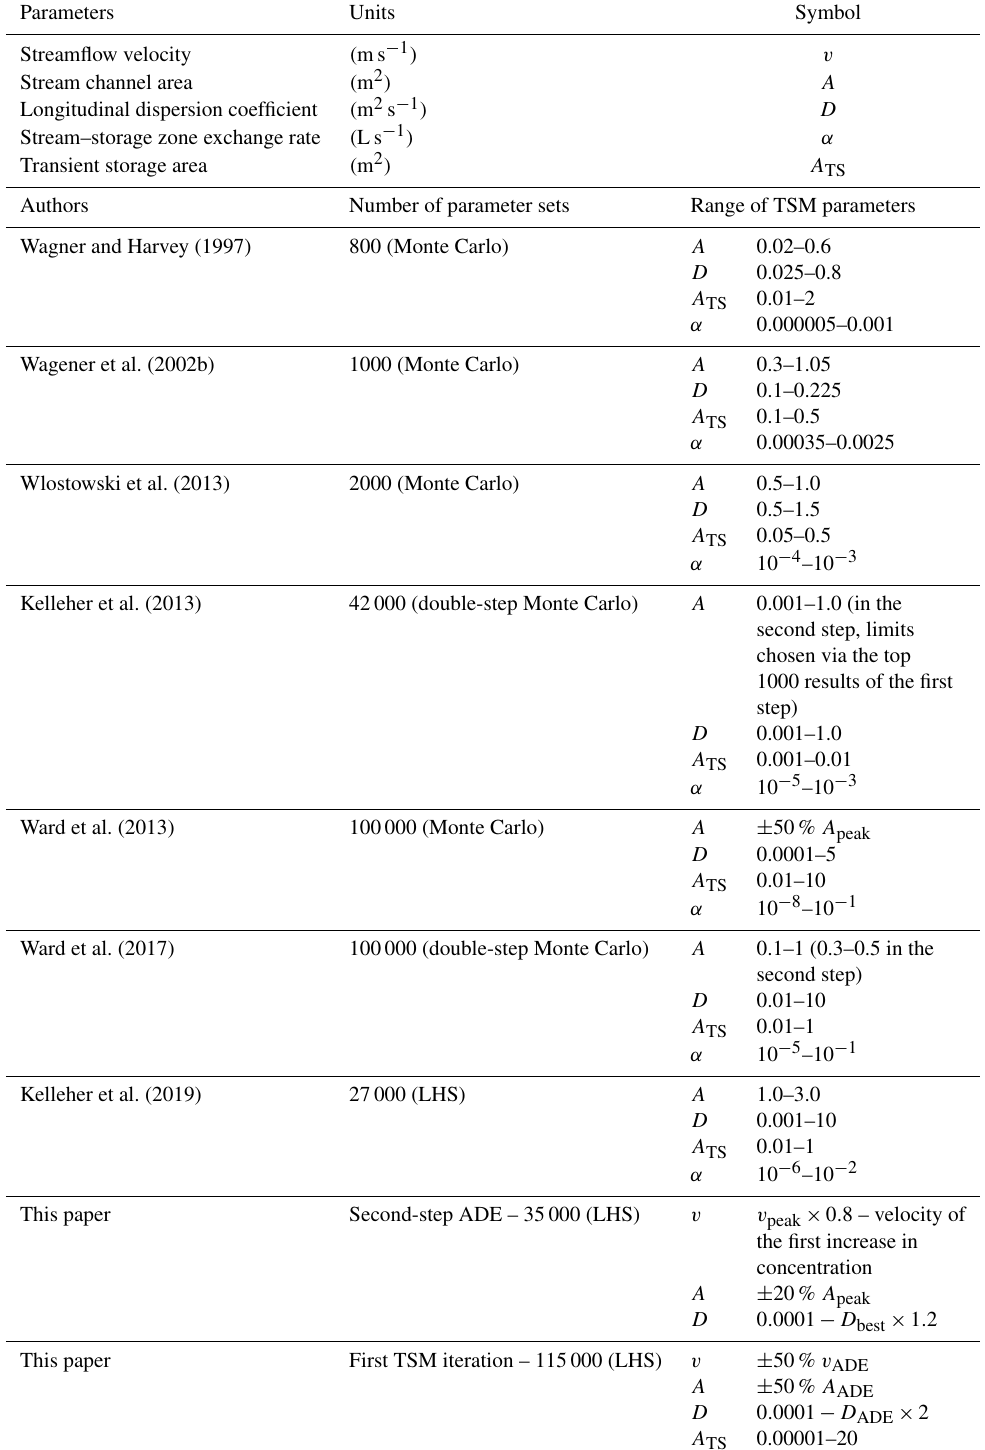
Table 1. Parameter names, abbreviations, and units together with a summary of publications that address the identifiability of model param- eters with random sampling approaches. We reported the used number of parameter sets and the parameter ranges, while in parentheses we reported the method used for the parameter sampling. “Double step” indicates that the sampling procedure was divided into two steps. In the first step, A varied across a broad range, and in the second step, it varied across a narrower range to cover the most sensitive range of the parameter domain. Each of the two steps investigated a number of parameter sets equal to half of the total number indicated in the